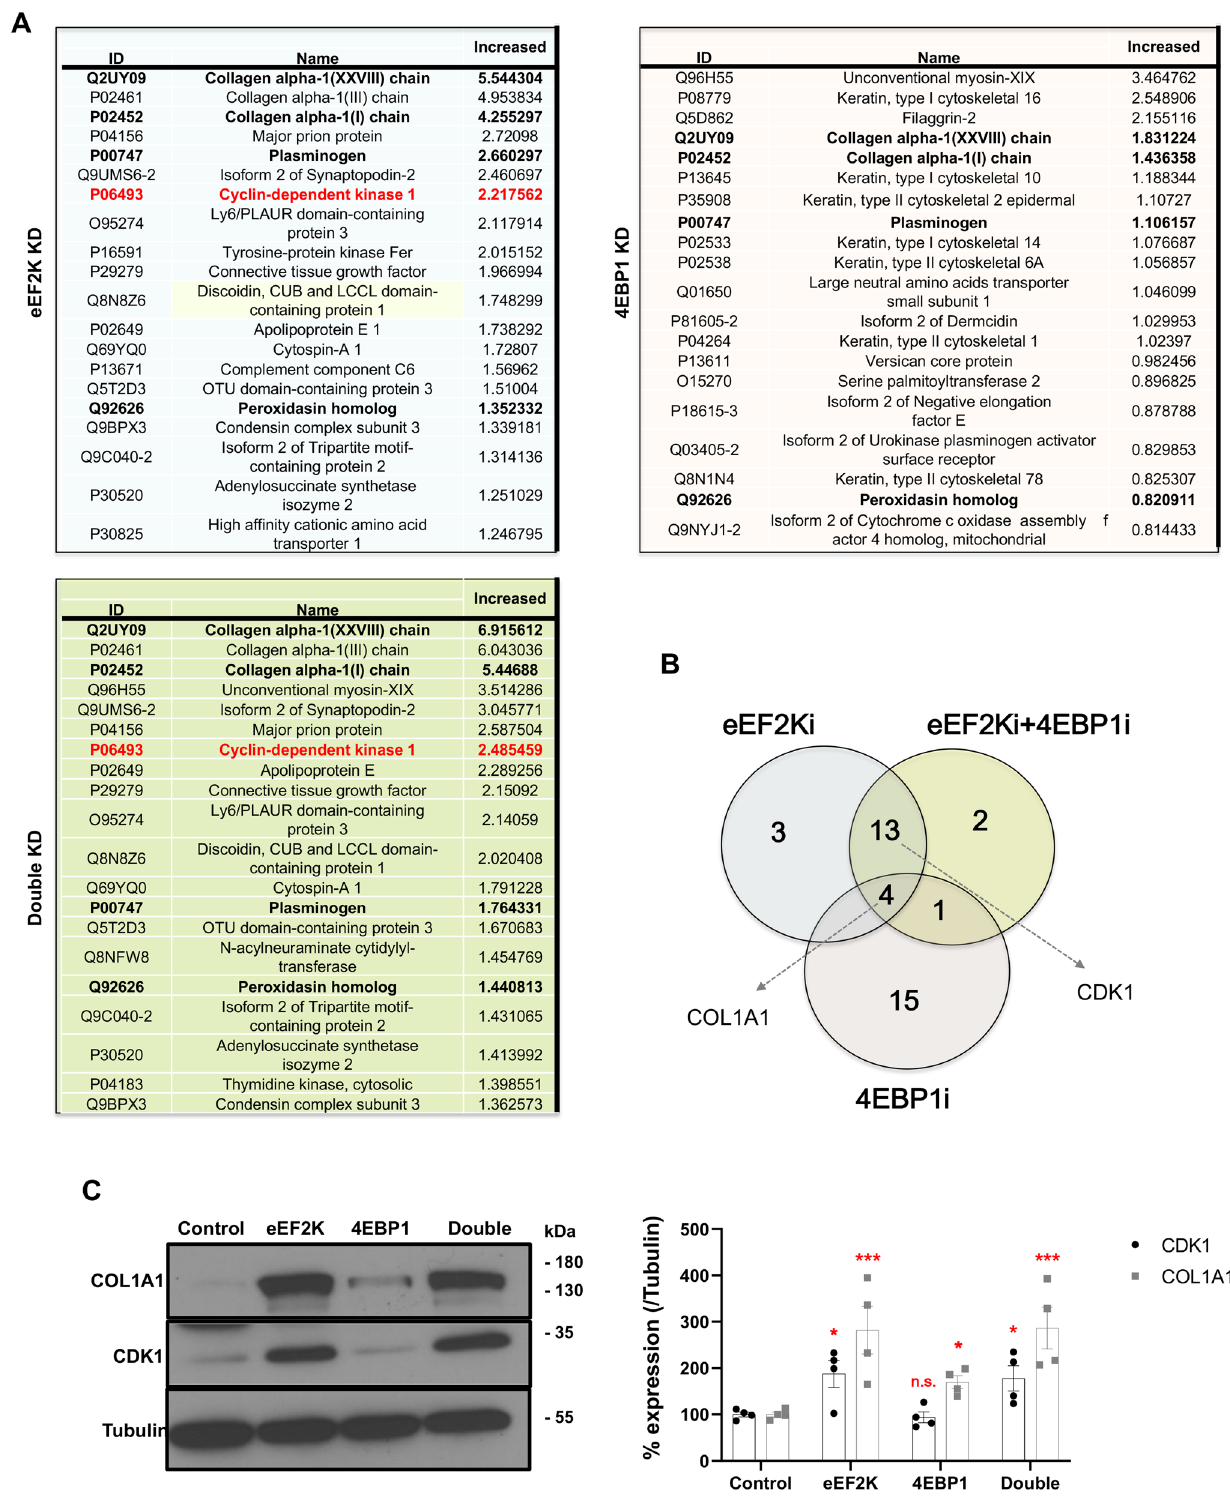
Figure 6. Induction and validation of COL1A1 and CDK1 following knockdown of eEF2K and/or 4EBP1 . ( A ) Top 20 up-regulated proteins from the LC–MS/MS analysis of eEF2K and/or 4EBP1 knocked-down (KD) HS578T cells. Common proteins are shown in bold. For full overlap of all proteins induced ≥ twofold following eEF2K and/or 4EBP1 depletion, see Supplementary Table S3. ( B ) Venn diagram showing the numbers of up-regulated proteins in the top 20 lists following eEF2K and/or 4EBP1 knockdown (i). COL1A1 (Collagen Type I Alpha 1 Chain) is elevated in all lines whereas CDK1 (Cyclin dependent kinase 1) is elevated following eEF2K but not 4EBP1 knockdown. ( C ) Western blot analysis showing that in accordance with the MS analysis, both COL1A1 and CDK1 proteins are significantly induced following eEF2K knockdown via RNAi, but only COL1A1 is significantly induced following 4EBP1 depletion in Hs578t cells. Left, a representative Western blot. Right, dot plot quantification of four independent experiments following eEF2K and/ or 4EBP1 silencing by RNAi. *Denotes P < 0.05; ** P < 0.01; *** P < 0.001 versus control by ANOVA; n.s. not significant; n =